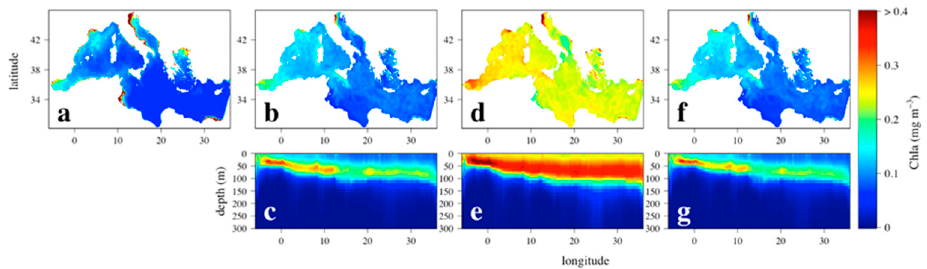
Figure 5. Average total chlorophyll (units mg chla m − 3 ) distribution for the year 2017. Transects are computed as latitude-averaged depth profiles for the same year (2017). ( a ) Satellite surface chloro- phyll data derived from CMEMS [39]; ( b ) surface chlorophyll for simulation EXP-1; ( c ) longitudinal chlorophyll transect for EXP-1; ( d ) surface chlorophyll for EXP-2; ( e ) longitudinal chlorophyll tran- sect for EXP-2; ( f ) surface chlorophyll for simulation EXP-3; and ( g ) longitudinal chlorophyll tran- sect for EXP-3. EXP-3.